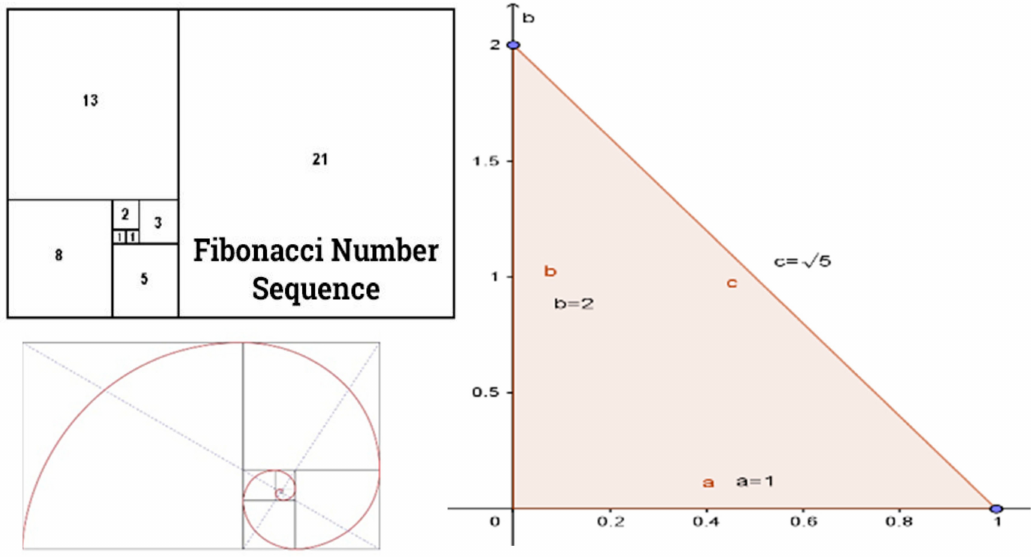
Figure 3. Visual representations of Golden